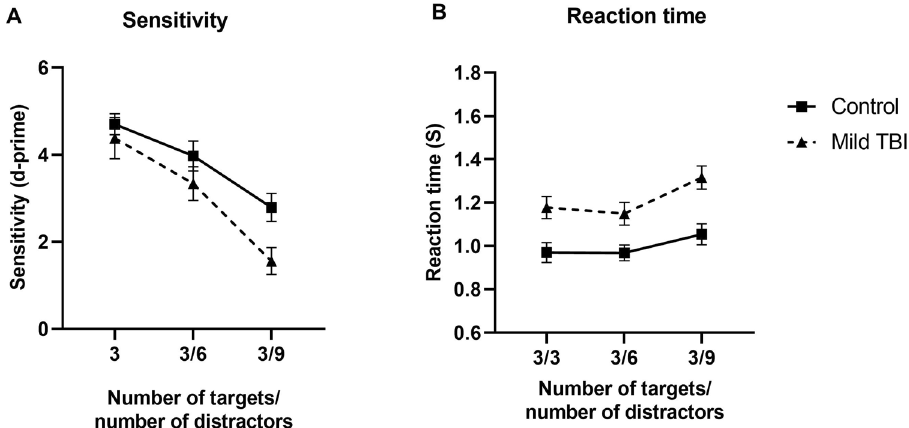
Figure 4. Sensitivity ( A ) and reaction time ( B ) as a function of the number of distractor dots for control participants and patients with mild TBI (different symbols). Error bars indicate 1 standard error of the